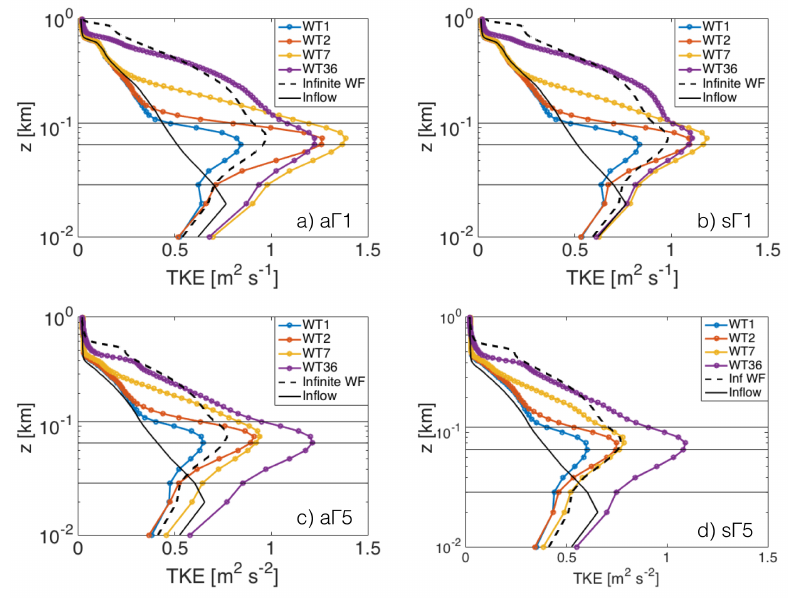
Figure 10. Vertical profiles of time- and spanwise-averaged TKE at the 1st, 2nd, 7th, and 36th turbine rows for the cases: ( a ) FS-a Γ 1; ( b ) FS-s Γ 1; ( c ) FS-a Γ 5; and ( d ) FS-s Γ 5. The black solid profile represents the TKE of the ABL inflow, and the black dashed profile represents the time- and horizontal-averaged TKE of the infinite wind farm with the same wind farm configuration. The black horizontal solid lines represents the top-tip, hub and bottom-tip